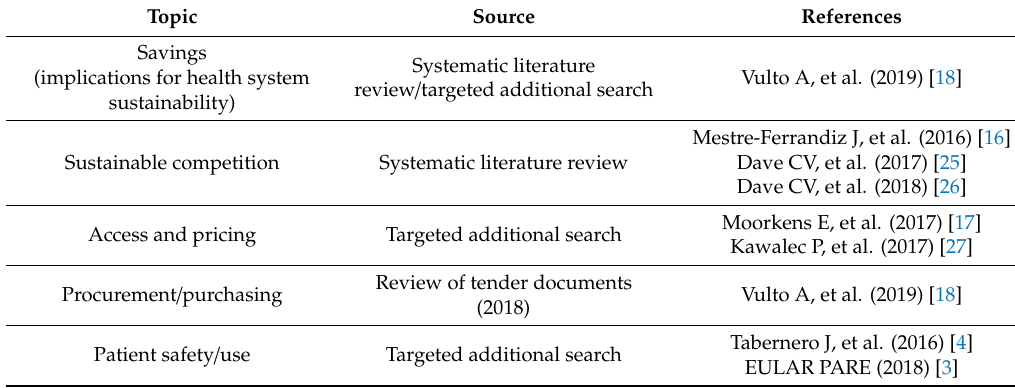
Table A2. Key literature identified during brainstorming (Delphi process stage 1).